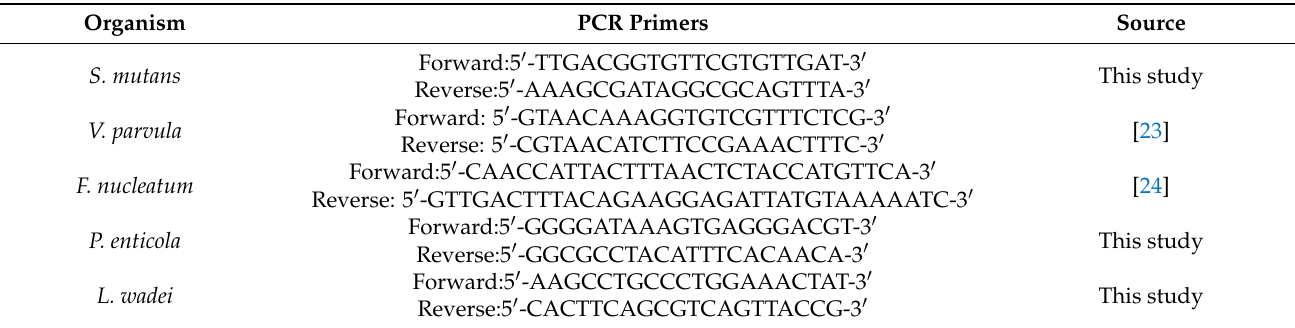
Table 1. Primers used in this